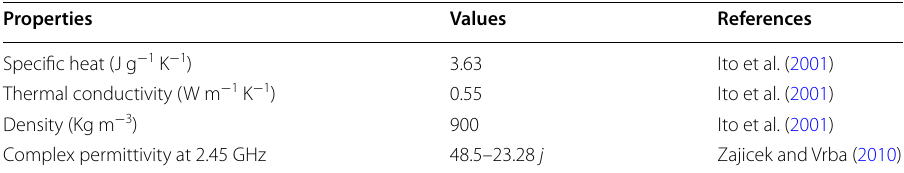
Table 1 Materials properties of the breast phantom Properties